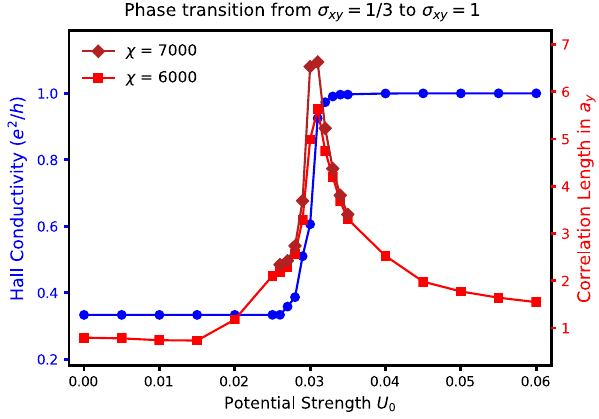
FIG. 6. DMRG simulation result on infinite cylinder geometry with circumference size L y ¼ 24 . 6 l B . ϕ ¼ 3 = 2 , n ¼ 1 = 2 , V V 1 , V V 1 . 6 , while changing the potential 1 ¼ 2 ¼ 3 ¼ 4 ¼ strength U 0 . The blue line represents the change of Hall conductivity, which is measured at bond dimension χ ¼ 2000 . Red lines represent the change of correlation length with bond dimensions χ ¼ 6000 ,